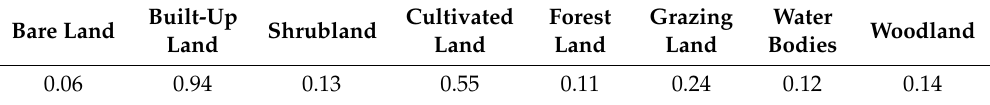
Table 7. Population density per square kilometer (km 2 ) in the